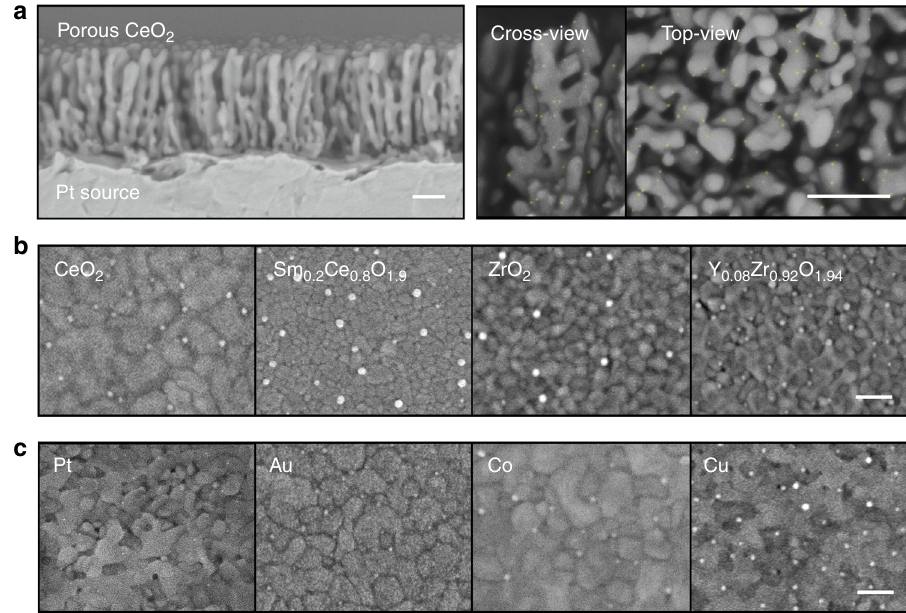
Fig. 3 Microscopic images of samples with various compositions and structuresarious. a Low (left) and high-magnitude (right) fi eld emission scanning electron microscopy (FE-SEM) images of synthesized Pt nanoparticles on a nanoporous CeO 2 thin fi lm. For clarity, the nanoparticles are highlighted as yellow. Top-view FE-SEM images of synthesized ( b ) Ni nanoparticles on pristine/doped CeO 2 and ZrO 2 surfaces, and ( c ) Pt, Au, Co, and Cu nanoparticles on Sm-doped CeO 2 surfaces. (scale bars = 100